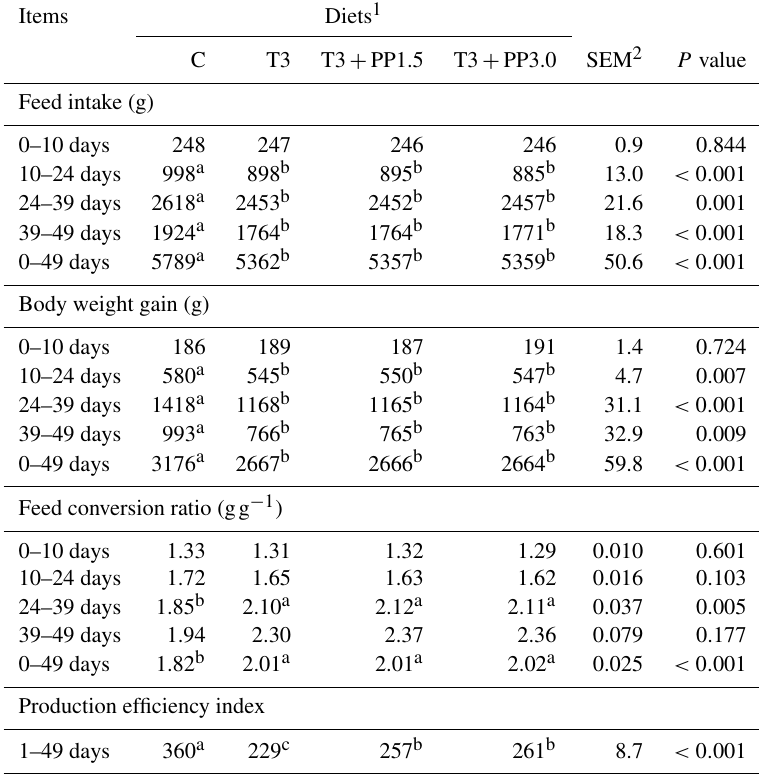
Table 3. Effects of dietary treatments on feed intake, body weight gain, and feed conversion ratio in broiler chickens at different periods of experiment. Items Diets 1 C T3 T3 +